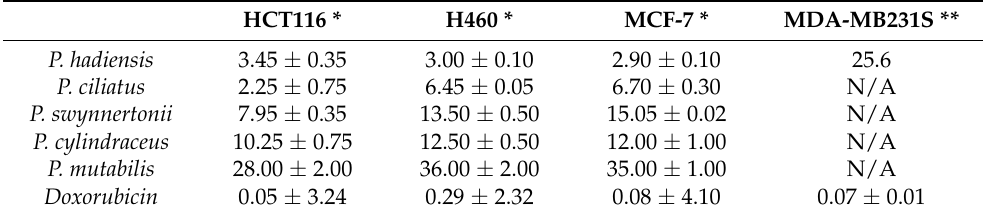
Table 3. IC 50 ( µ g/mL) values for five selected acetonic extracts in HCT116, MCF-7, H460 and MDA-MB231S cell